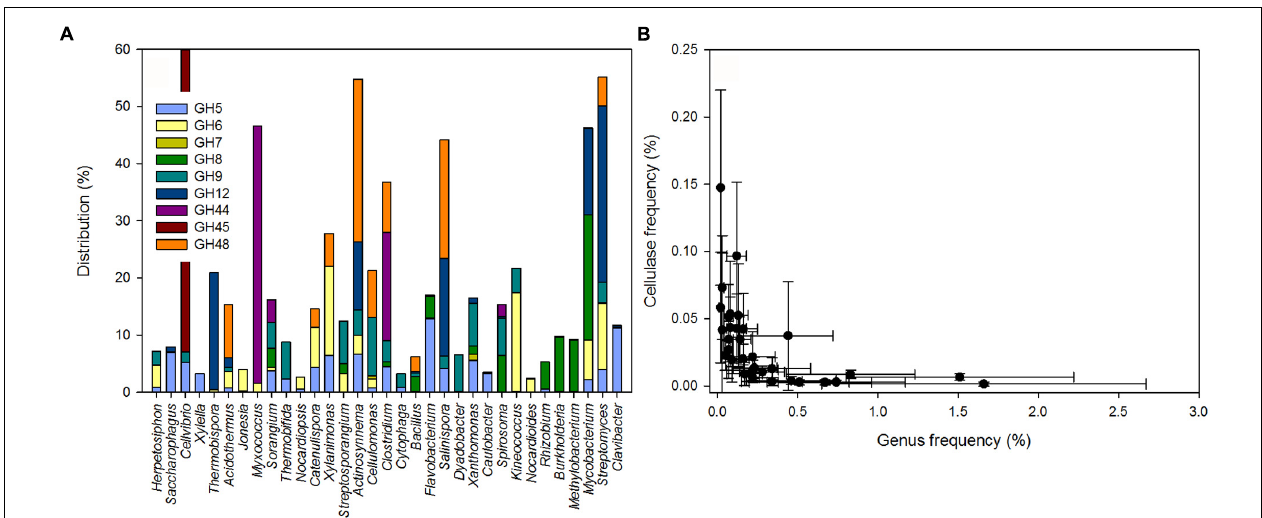
FIGURE 2 | (A) Distribution of cellulolytic enzymes in potential bacterial cellulose degraders. (B) Relationship between the lineage specific cellulase frequency and the potential cellulose degrading genera in the leaf litter metagenomes ( P Spearman < 0.01).